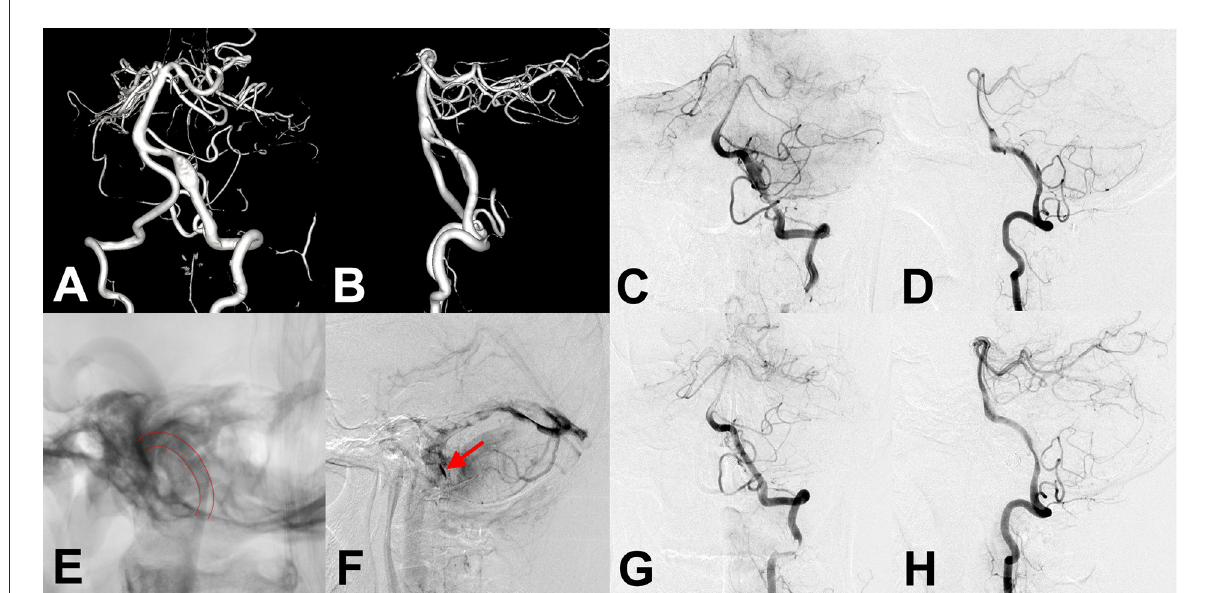
FIGURE3 (A,B) Preoperative anteroposterior and lateral angiography showed an unruptured vertebral artery fusiform aneurysm. (C,D,F) Immediate angiography after stenting showed residual aneurysm with significant stasis. (E) Flow diverter stent showed successful deployment in intraoperative angiography (lines). (G,H) Follow-up angiography at 6 months after the procedure showed an aneurysm occlusion completely, while accompanied by parent artery stenosis. The patient showed no clinical